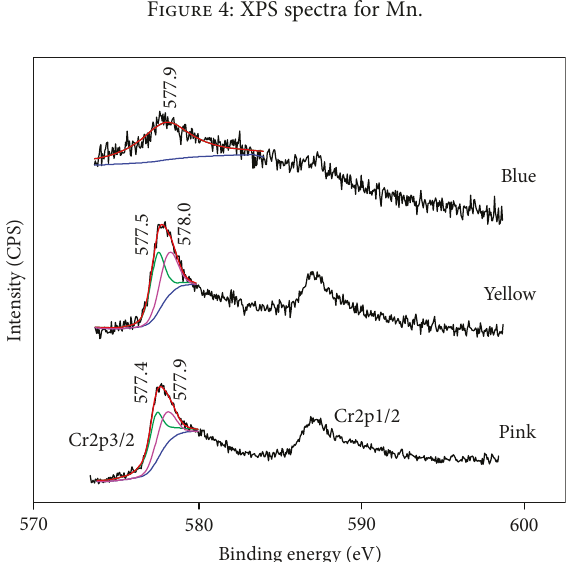
Figure 4: XPS spectra for Mn.